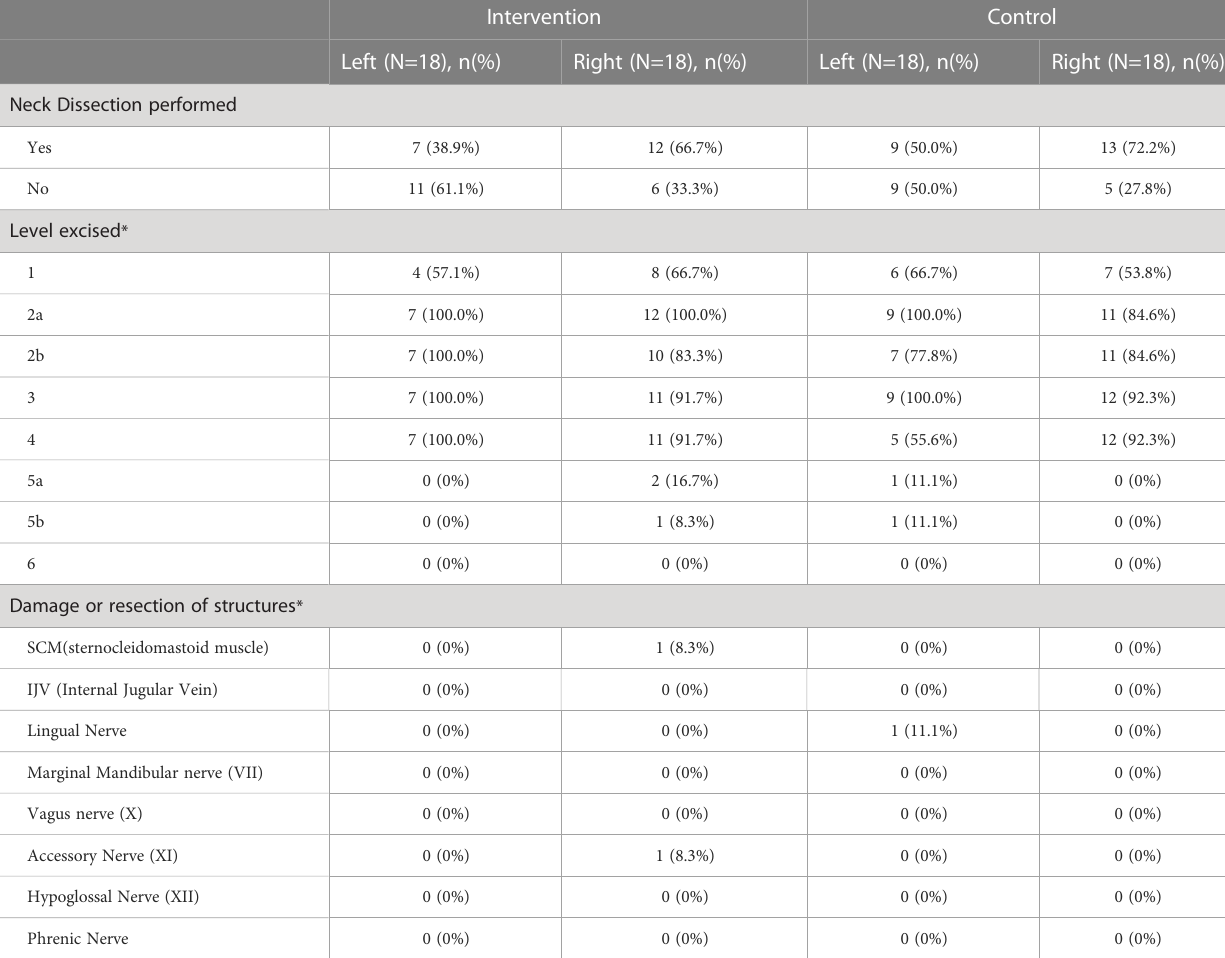
*The proportions are calculated based on the number of participants with neck dissection performed. *Comorbidity list 1: Anxiety, Depression, Mental Illness.Comorbidity list2: Angina or heart condition, Asthma, Chronic lung disease, Peripheral vascular disease, Stroke, High blood pressure.Comorbidity list 3: Dementia, Parkinson ’ s disease, Multiple sclerosis.Comorbidity list 4: Arthritis, osteoporosis, diabetes, digestive problems.Comorbidity list 5: Cancer (other than HNC). † Simple pain relief medication: Aspirin, Ibuprofen, Paracetamol.Complex pain relief medication: Co-codamol, Codeine, Dihydrocodeine, Diclofenac, Gabapentin, Morphine, Naproxen, Pxycodone, Tramadol or other